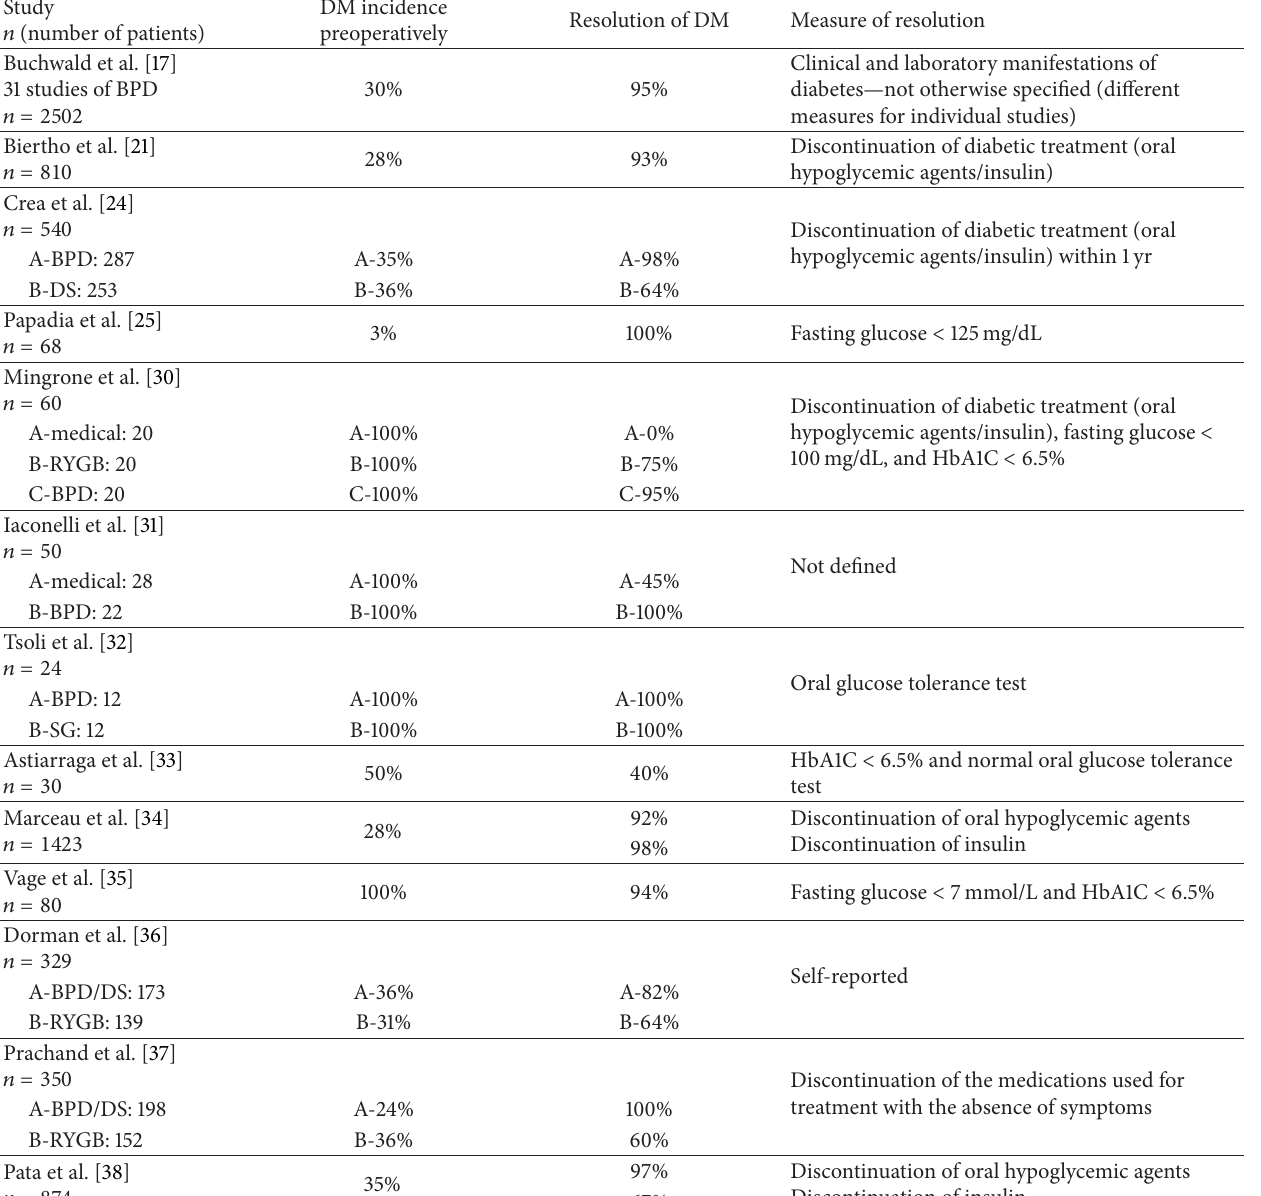
Table 1: Effect of biliopancreatic diversion with duodenal switch on